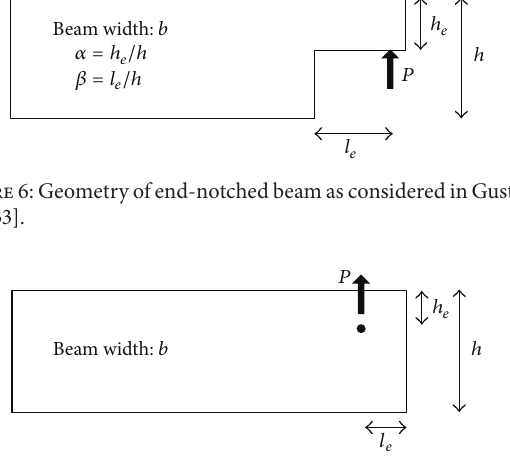
Figure 7: Geometry of beam considered in Jensen